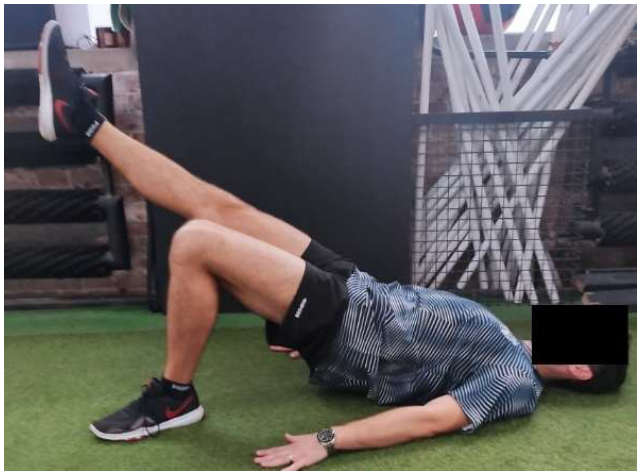
Figure A2. Unilateral Glute Bridge.